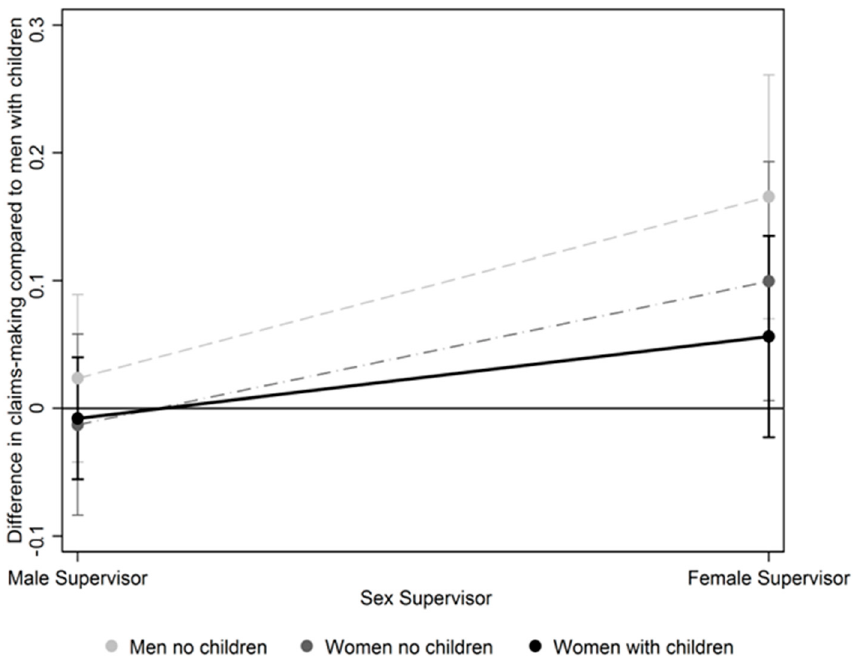
Figure 3. Gender differences in estimated values for claims-making according to supervisor’s gender. Note: Based on results model 1, Table 6. Figure shows interaction of supervisor-sex and family status; 90% Confidence Intervals, using stata-command contrast.